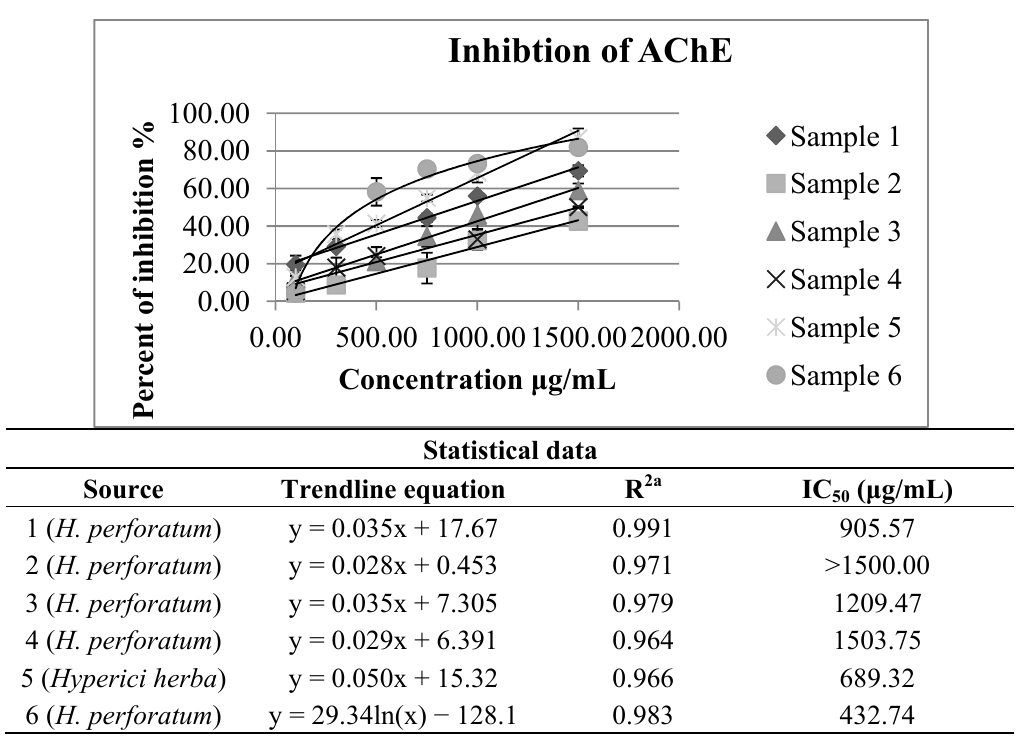
Figure 3. Inhibition of acetylcholinesterase by investigated H. perforatum extracts and by that obtained from Hyperici herba